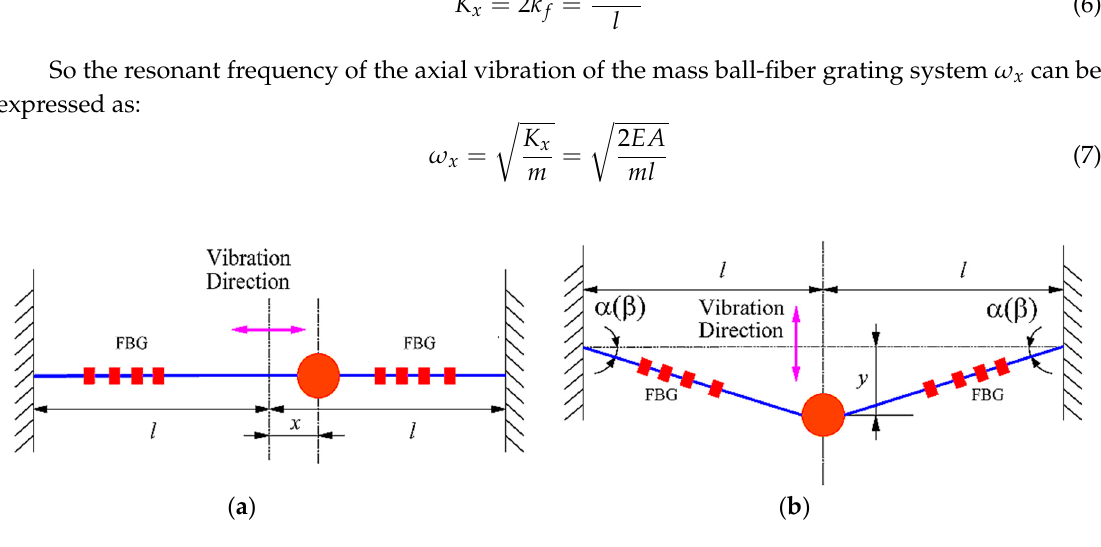
Figure 3. Equivalent vibration model of sensor’s mass ball optical fiber system: ( a ) axial vibration model along the X direction and ( b ) lateral vibration model along the Y direction.